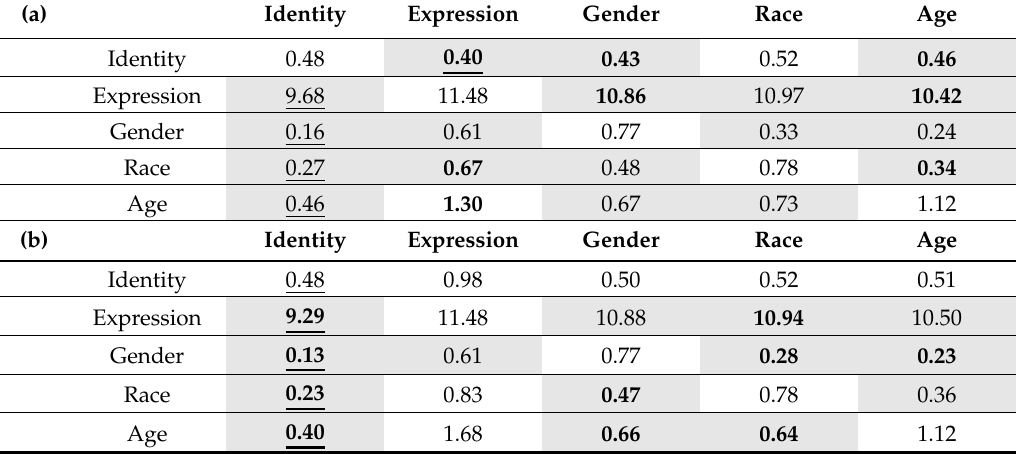
Table 1. Recognition error (%) of dual task learning with independent tasks ( a ), and correlated tasks ( b ).